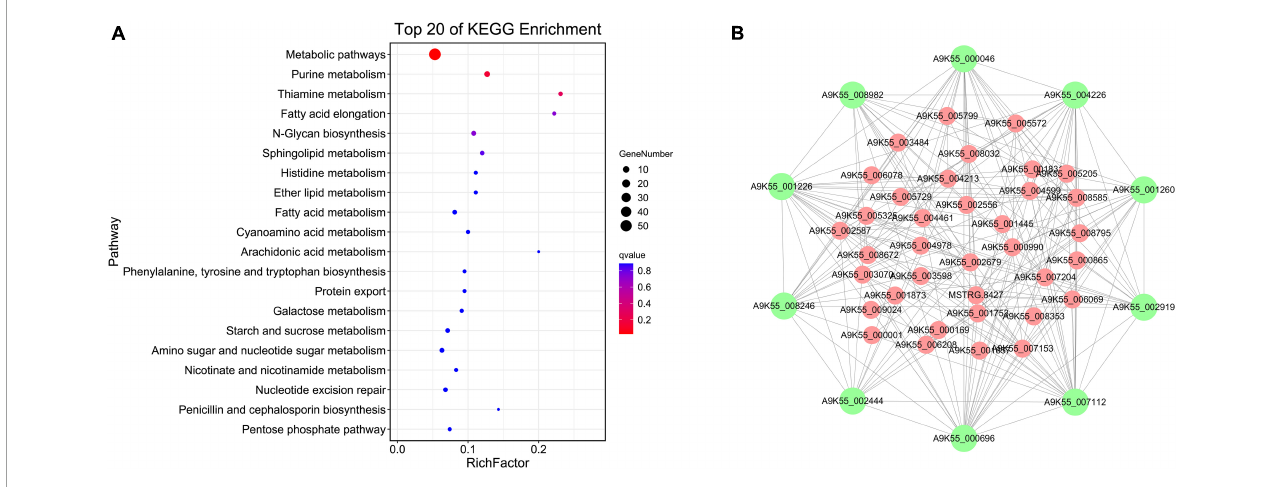
FIGURE4 Co-expression network analysis of floral white module. (A) KEGG enrichment bubble diagram for floral white module. (B) Regulation of the floral white module gene